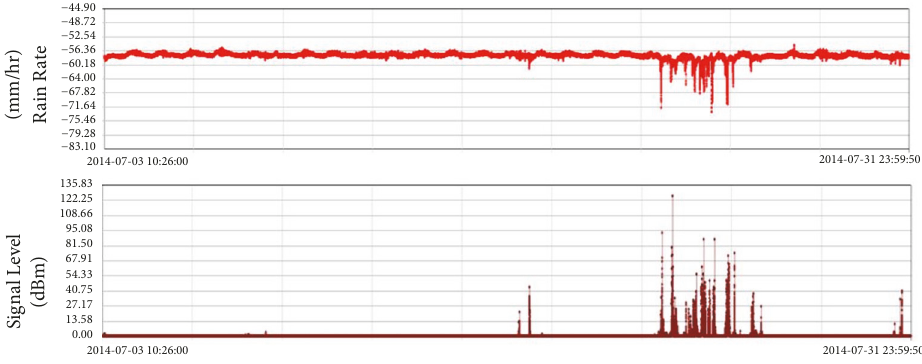
Figure 2: Variation of 12.25GHz signal attenuation [36].